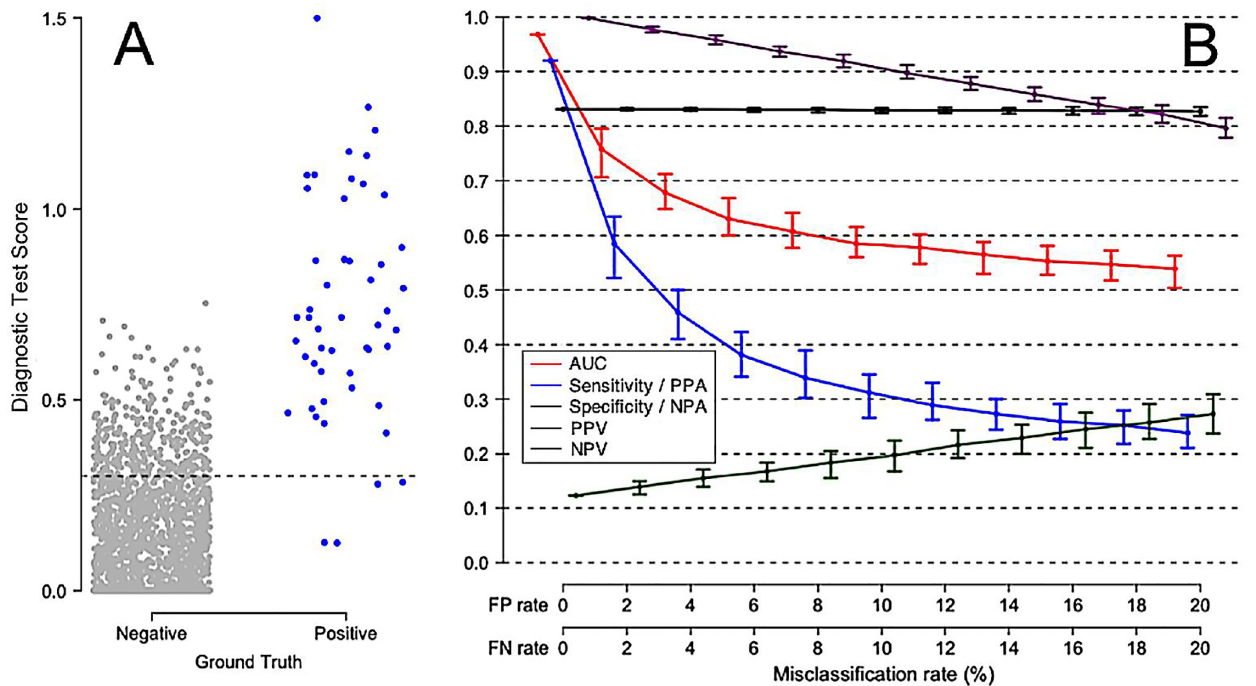
Fig 6. A simulated screening test in a low prevalence setting, for example for a relatively uncommon infectious disease. In this scenario ground truth positive patients are equally likely to be misclassified as negative patients (A) Representation of Ground Truth for 1950 negative patients, and 50 positive patients. with some overlap between the positive and negative ground truth distributions. (B) Apparent performance of diagnostic test, as a function of the misclassification rate of the comparator. The error bars describe 95% empirical confidence intervals about medians, computed over 100 simulation cycles. True test performance is indicated when the FP and FN rates are each 0%. The terms Sensitivity and Specificity are appropriate when there is no misclassification in the comparator (FP rate = FN rate = 0%). The terms Positive Percent Agreement (PPA) and Negative Percent Agreement (NPA) should be used in place of Sensitivity and Specificity, respectively, when the comparator is known to contain